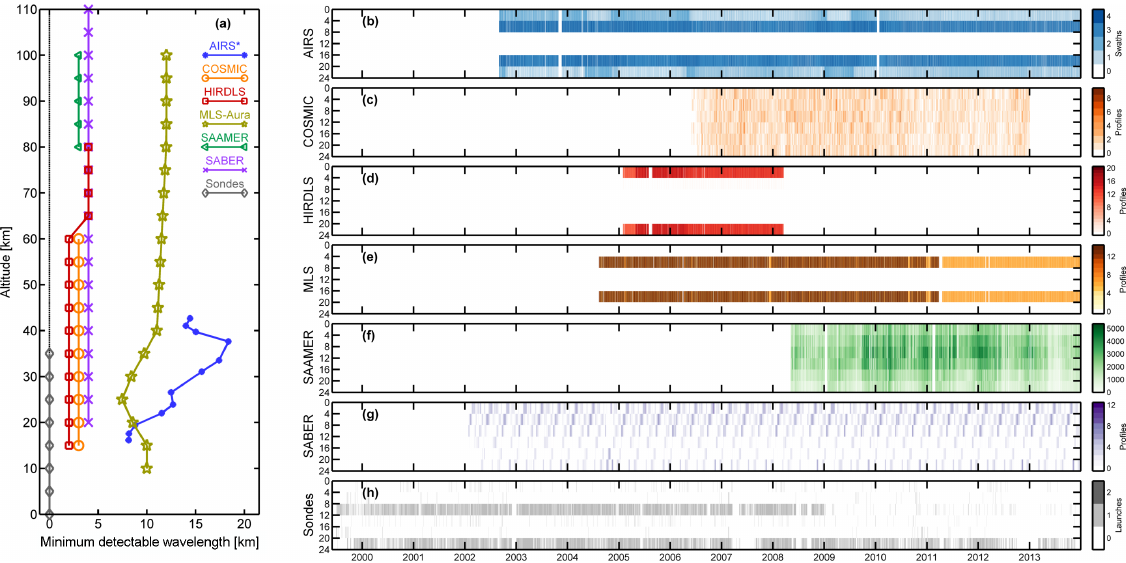
Figure 6. (a) Height coverage of each data set, with the approximate vertical resolution of each data set indicated at each altitude. Marker symbols are arbitrarily located and are only included to assist in uniquely identifying each series, with the exception of AIRS where they indicate the actual height levels analysed. (b–h) Temporal coverage of each data set. Each panel shows the number of measurements per 4h period available for a given instrument for each day from 1999 to 2013, with time within each day on the vertical axis and days on the horizontal axis. Instrument are indicated by the text label at the left of each panel. All times are